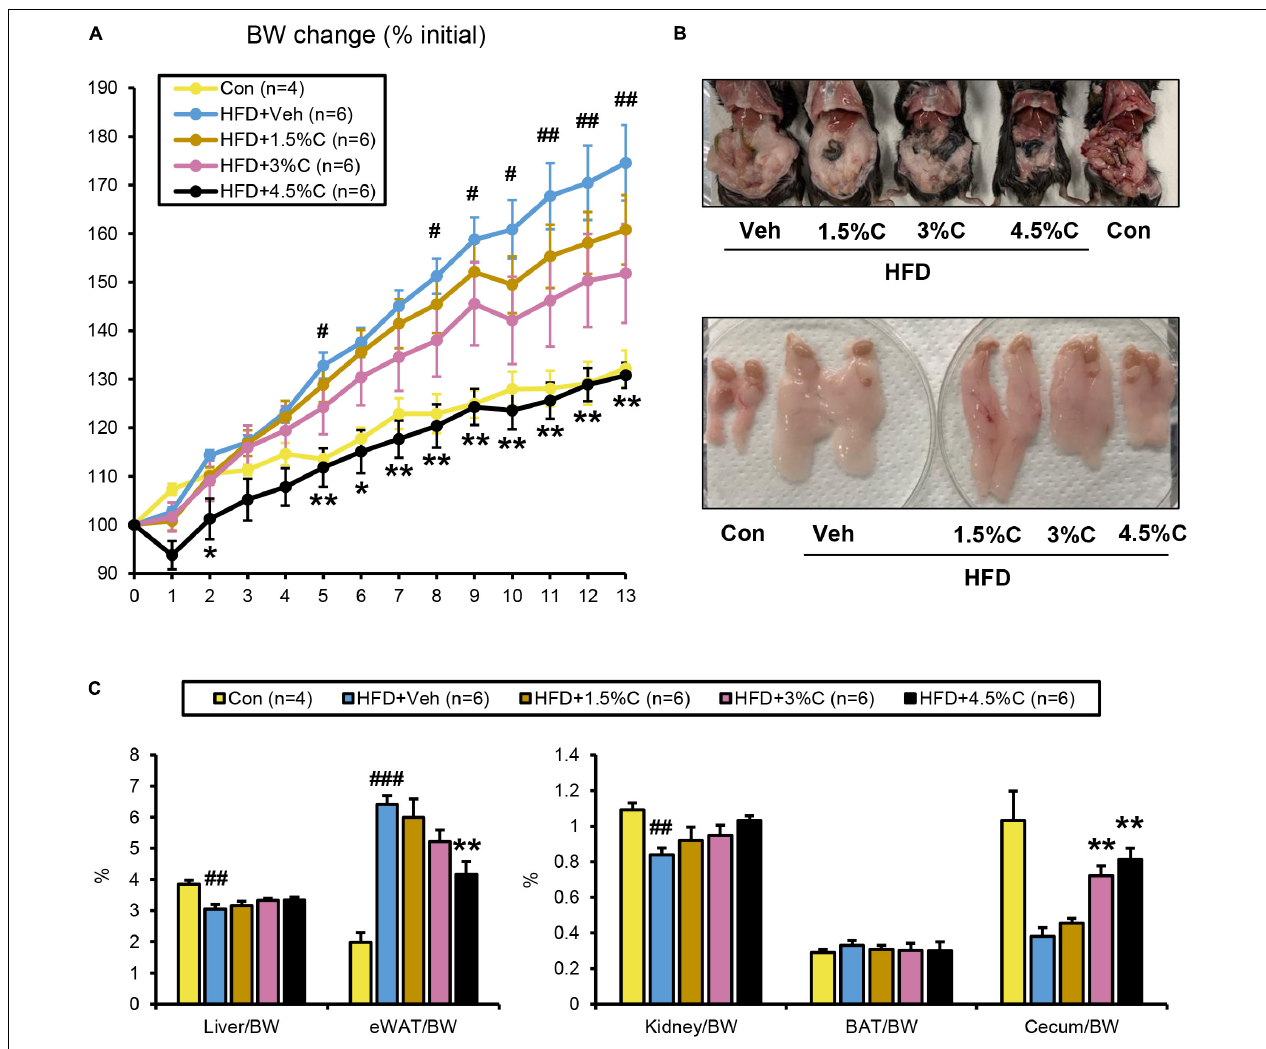
FIGURE 6 | HFD containing 4.5% acidic activated charcoal showed the strongest anti-obesity effect after 13 weeks of treatment. (A) Changes in BW. (B) Gross appearance of abdominal organs (upper panel) and epididymal white adipose tissue (eWAT) (lower panel) derived from five representative groups of mice. (C) Weights of the liver, eWAT, kidney, BAT, and cecum. Values were corrected by body weight (BW). Data are expressed as the mean ± SEM. Statistical analysis was performed using a one-way analysis of variance (ANOVA) with the Bonferroni’s correction. * P < 0.05, and ** P < 0.01 between the HFD + Veh group and the HFD + C group. # P < 0.05, ## P < 0.01, and ### P < 0.001 between the HFD + Veh group and the Con